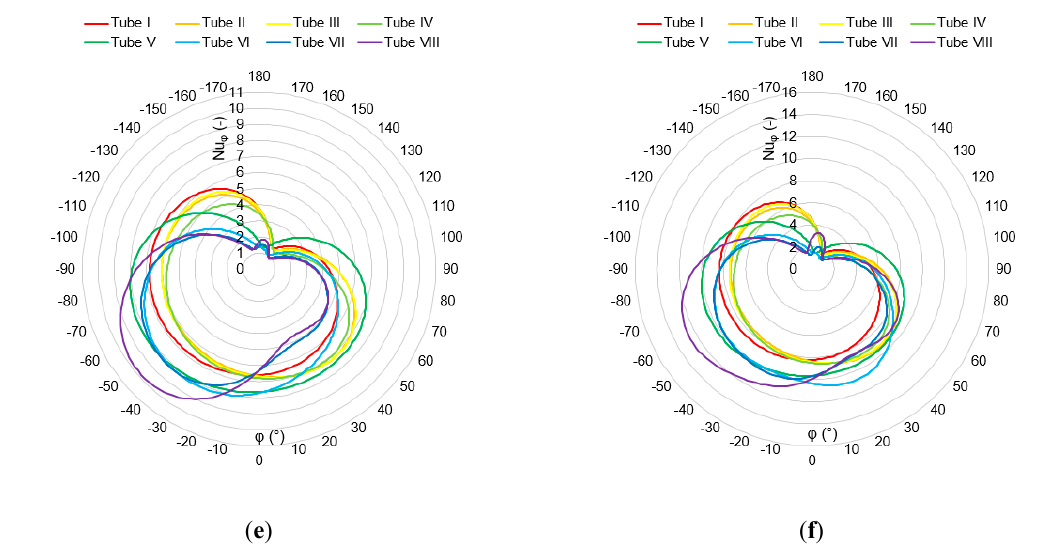
Figure 10. The local Nusselt numbers Nu φ for different configurations of the tube array 4×4 with the tube ratio spacing S/D of 2: ( a ) base configuration at Ra = 1.3 × 10 4 ; ( b ) base configuration at Ra = 3.7 × 10 4 ; ( c ) concave configuration at Ra = 1.3 × 10 4 ; ( d ) concave configuration at Ra = 3.7 × 10 4 ; ( e ) convex configuration at Ra = 1.3 × 10 4 ; ( f ) convex configuration at Ra = 3.7 × 10 4 .